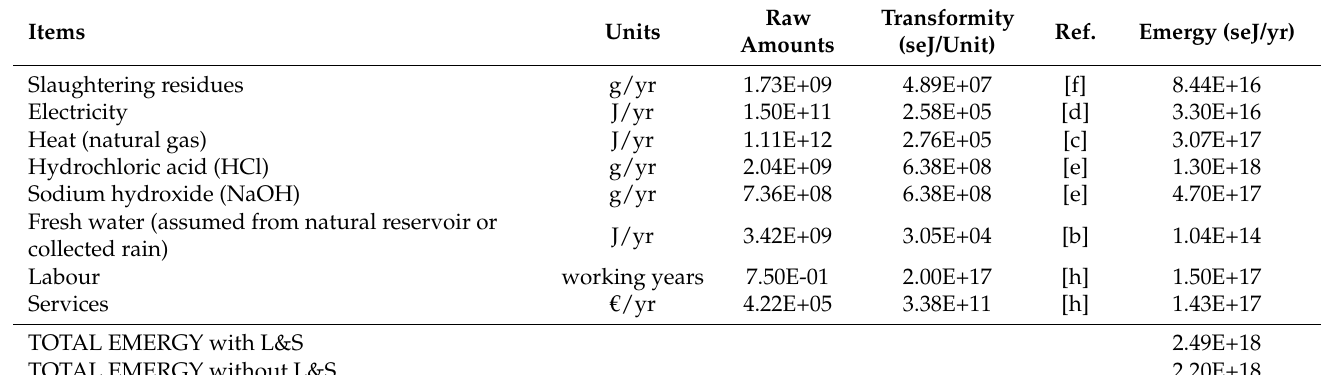
Table 6. Emergy table of hydrolysis.